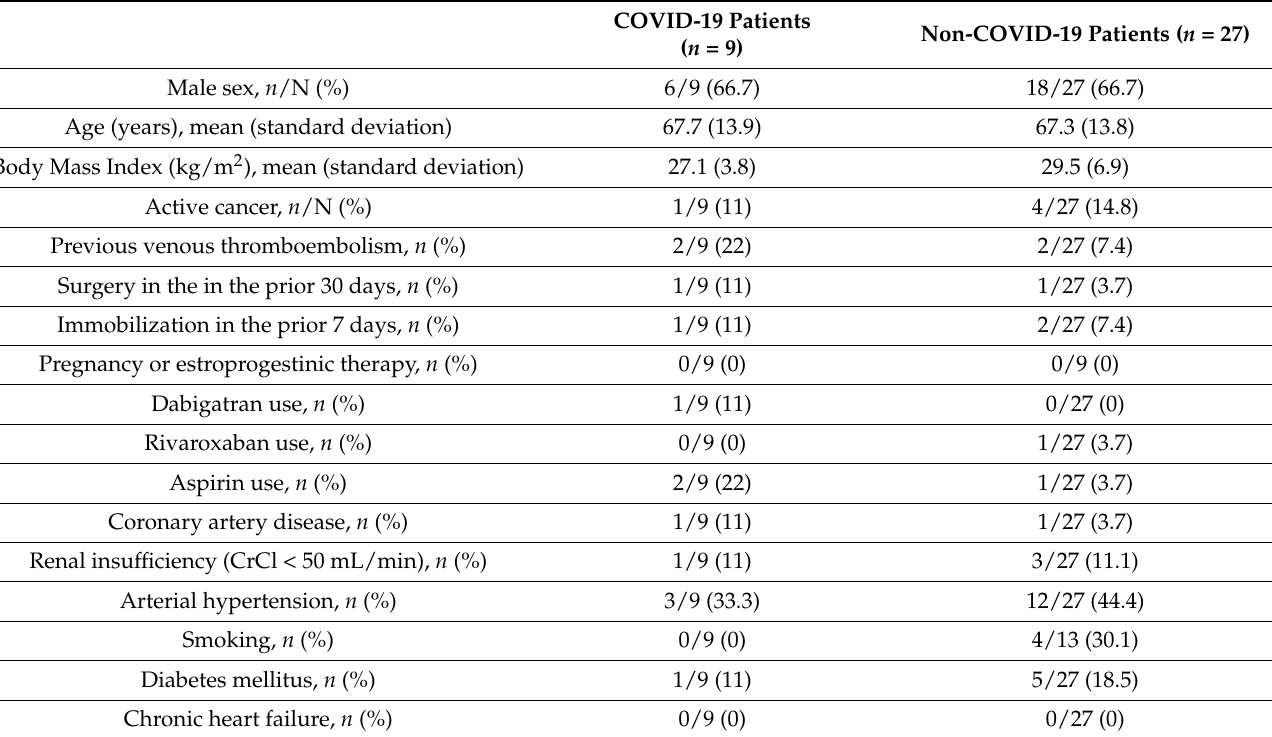
Table 1. Demographic and baseline